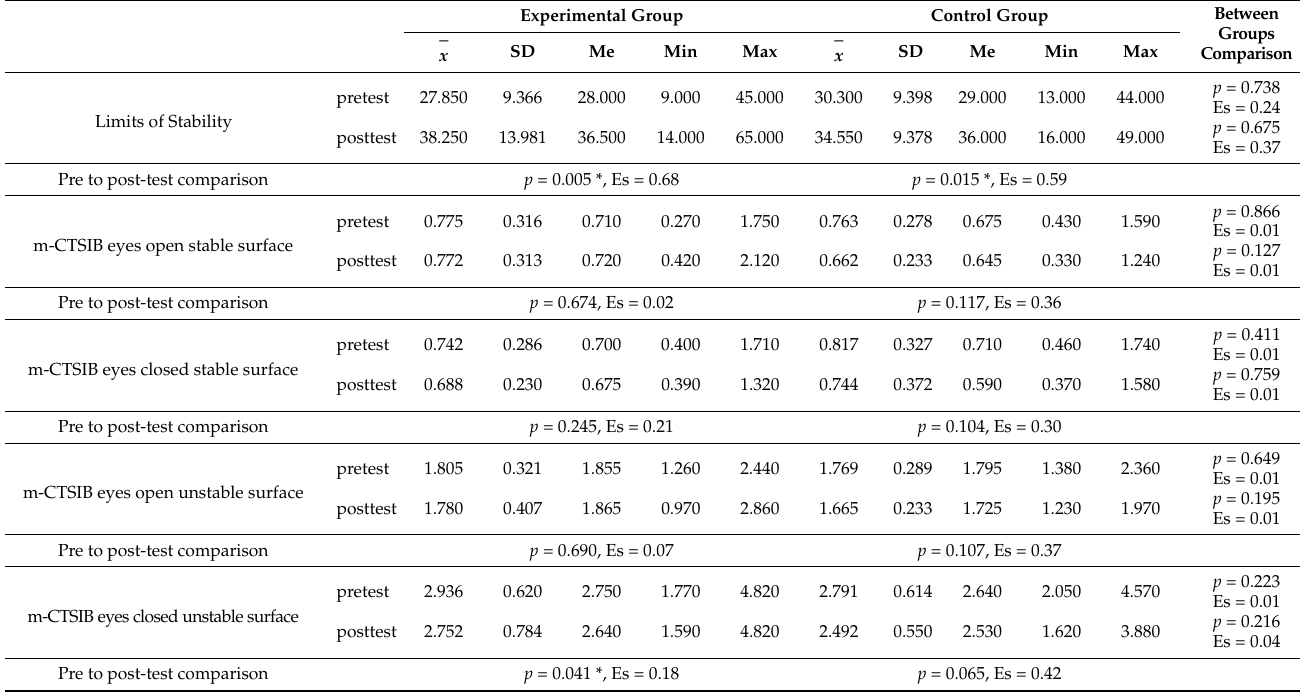
Table 5. Limits of Stability (LoS) and Modified Clinical Test of Sensory Interaction on Balance (m-CTSIB) results. Experimental